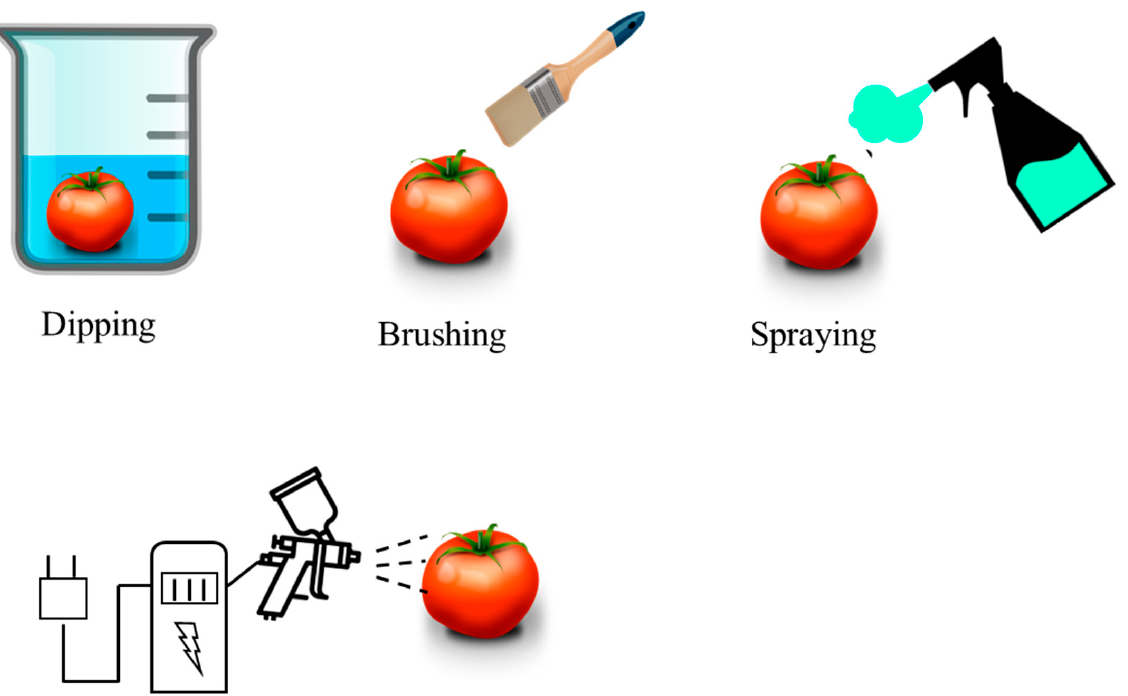
Figure 2. Diagram of the different coating methods.